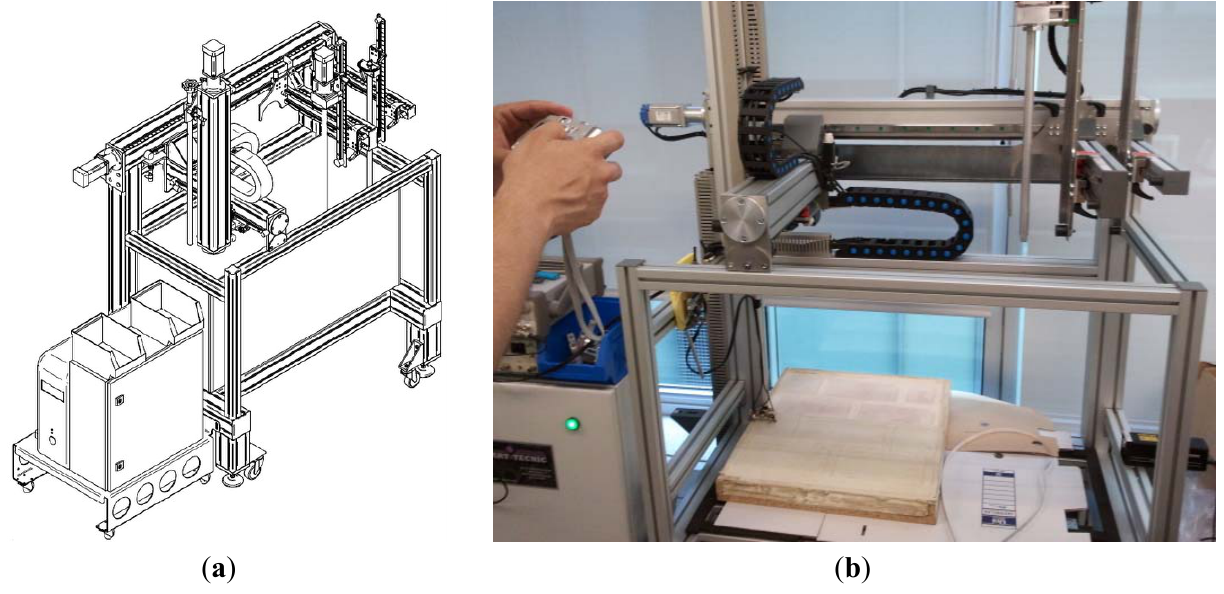
Figure 3. Artitecnic (Ibi, Spain) DS4, X-Y-Z automatic positioning system. ( a ) Schematics; ( b ) Photograph scanning the test